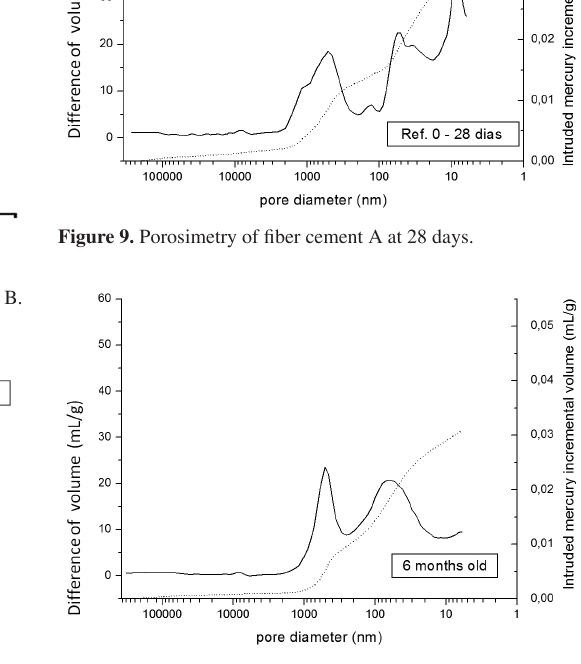
Figure 10. Porosimetry of fiber cement A at six months of age.